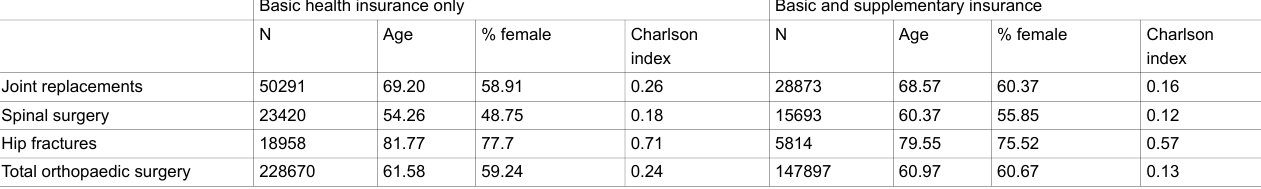
Table 2: Demographic structure of patients with major orthopaedic interventions across type of health insurance for 2003–2005 (age